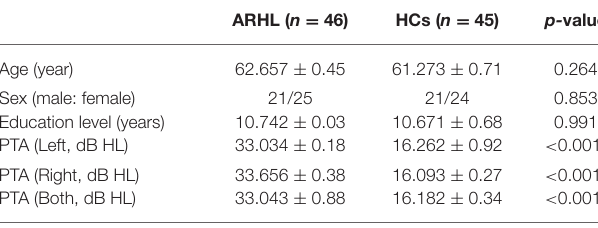
TABLE 1 | Demographics of the ARHL and HCs.